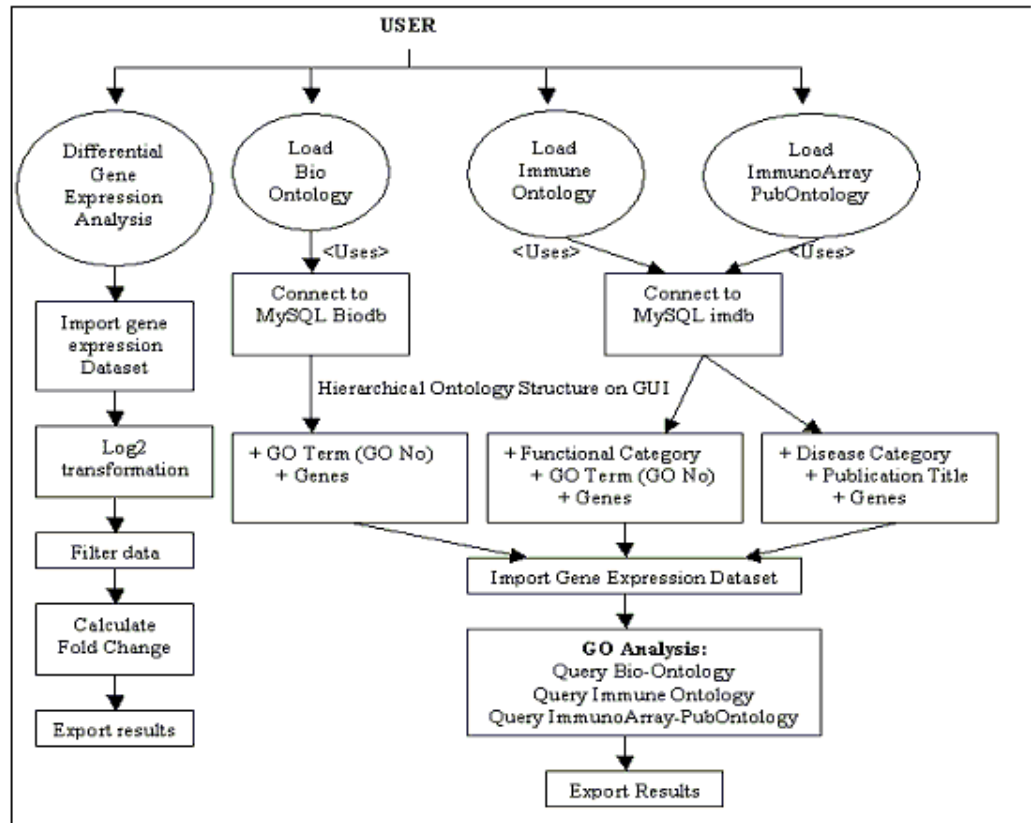
Figure 1. The structure of the Immune Ontologiser modelling its functionality. The Immune Ontologiser consists of four panels. The “Differential Gene Expression Analysis” panel requires the import of gene expression data, log2 transformation, and data filtering and finally the identification of differentially expressed genes. The “Bio-Ontology”, “Immune-Ontology” and ImmunoArray-PubOntology” connect to the underlying MySQL database representing the data as various hierarchical trees on the interface. This is followed by the querying of the hierarchical tree type of interest with the users microarray gene